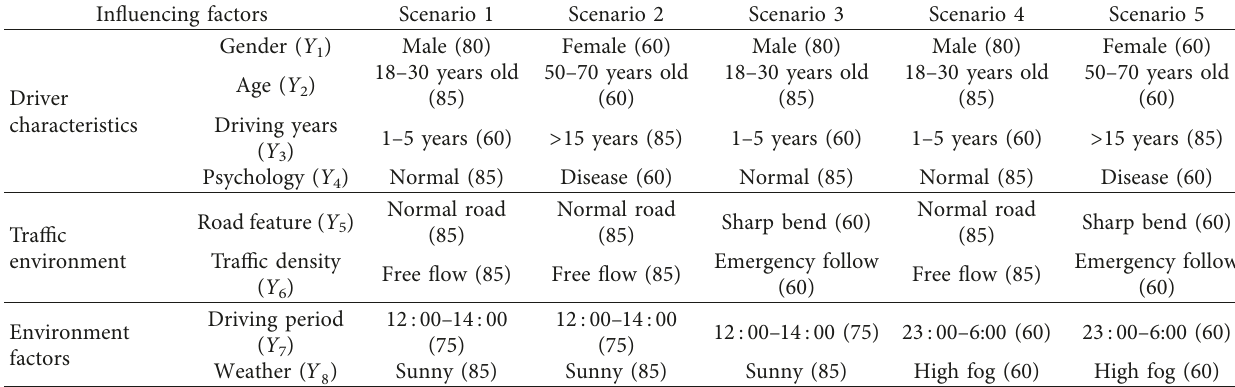
Table 4: Simulation parameters of different scenarios.